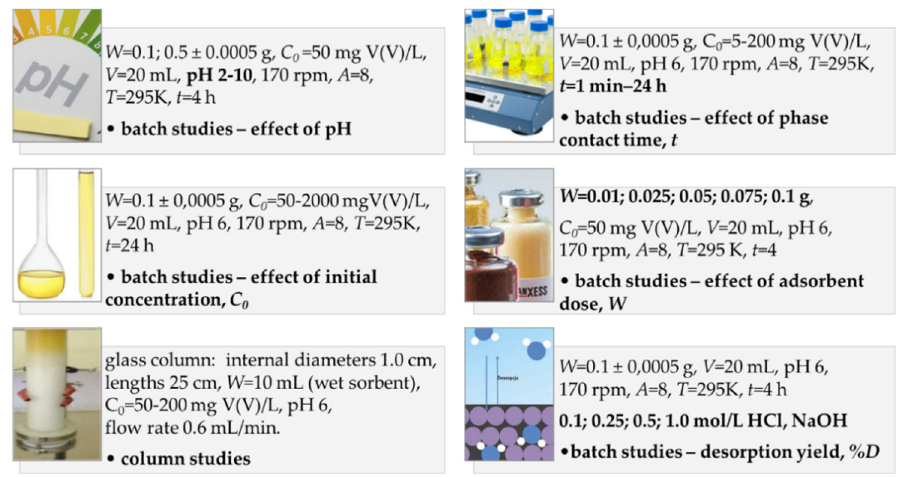
Figure 12. Experimental parameters applied in the vanadium(V) adsorption.